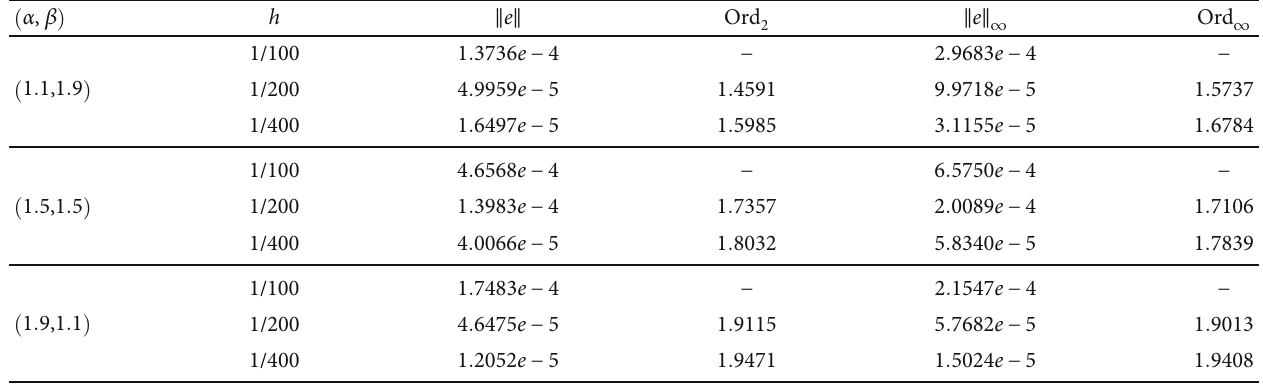
Table 3: l 2 -and l ∞ -errors and their convergence orders of (28) – (30) for 1 < α < 2 in the spatial direction for (73) with τ = 1/2000 for Example